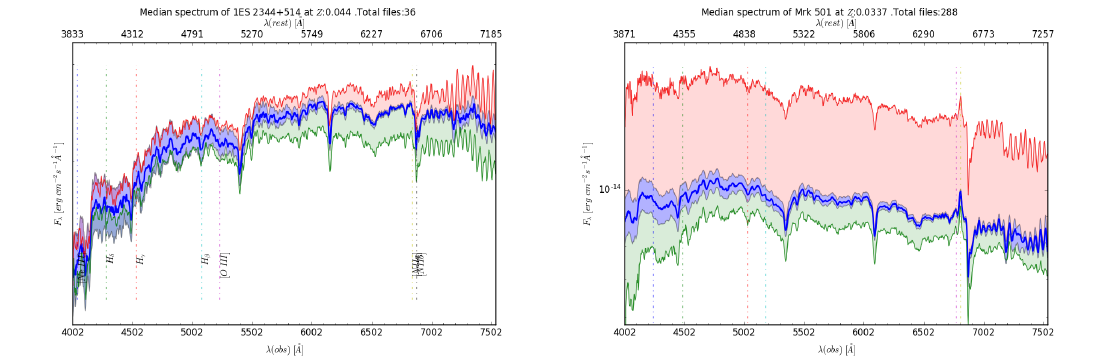
Figure 3. Median spectra computed for two objects dominated by the stellar population emission. Curves represent the same as in Figure 1.